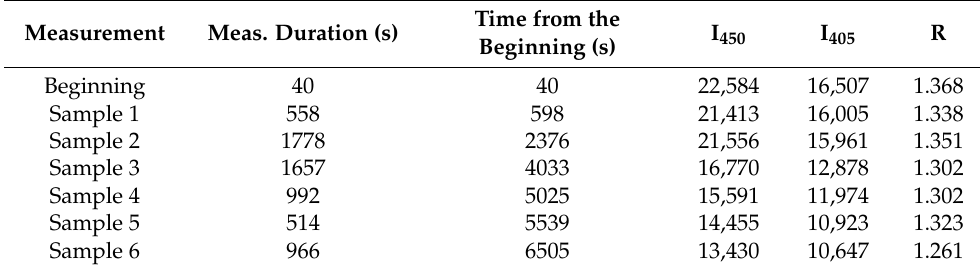
Table 2. Values measured in buffer solution with pH = 7.0.